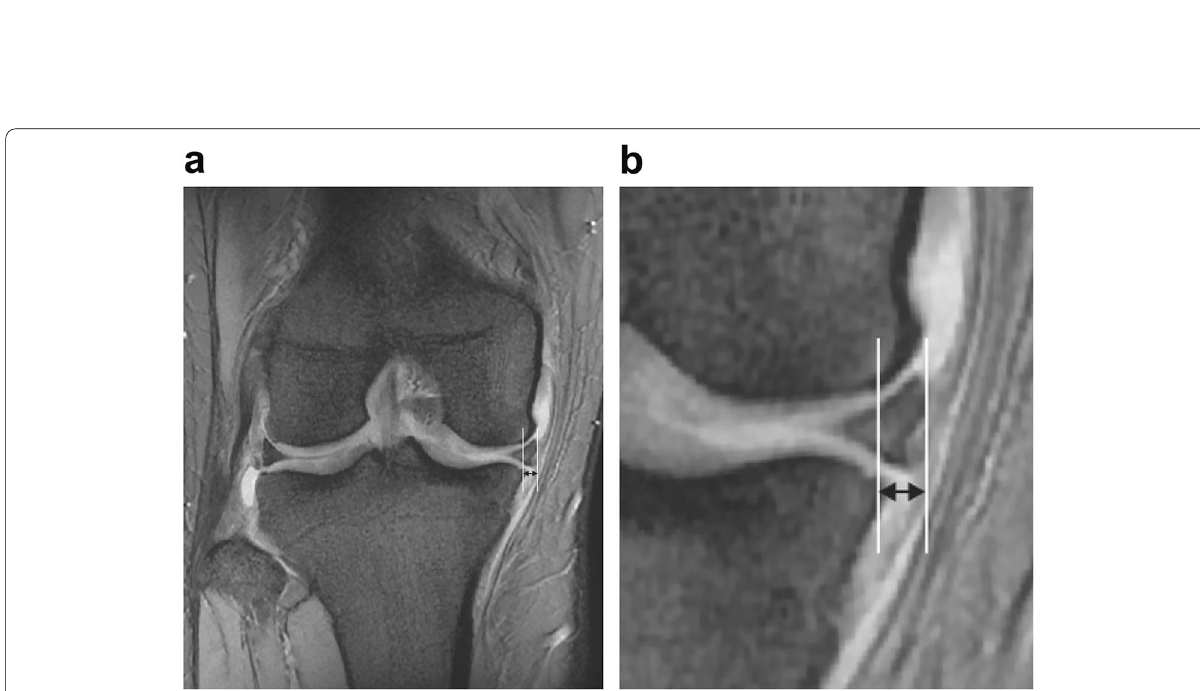
Fig. 3 Medial radial displacement measurements on magnetic resonance imaging. a The medial radial displacement (MRD) measurement was first performed by drawing a vertical line on the medial edge of the tibial plateau. The length of another line extending from the first line to the medial edge of the meniscus was defined as the meniscal extrusion. The MRD is indicated by a black arrow. b Enlarged view of the part corresponding to the MRD in Fig 3 a . The MRD is indicated by a black